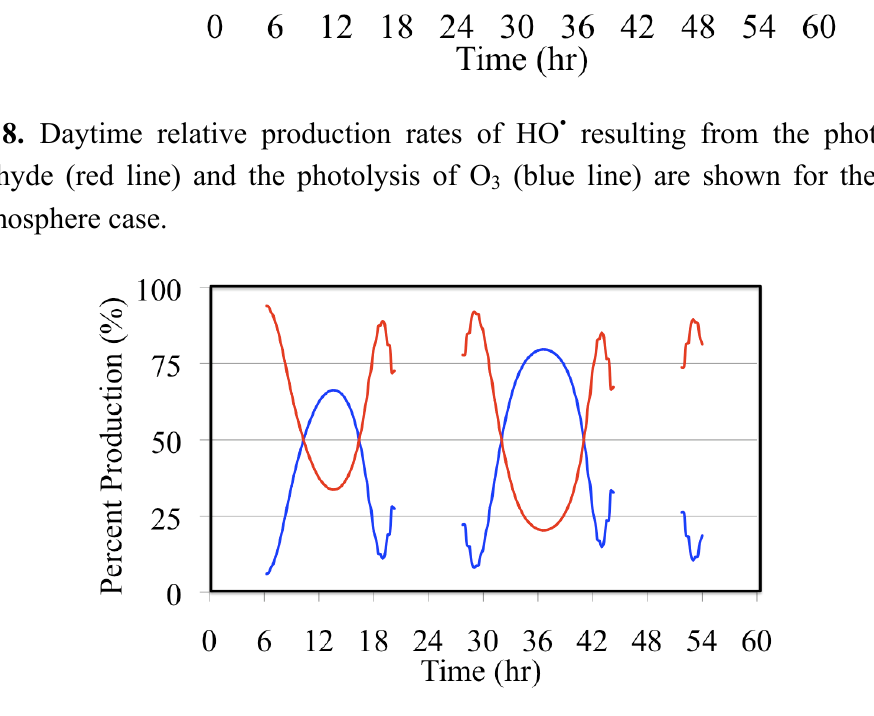
(blue line) are shown for the polluted 3